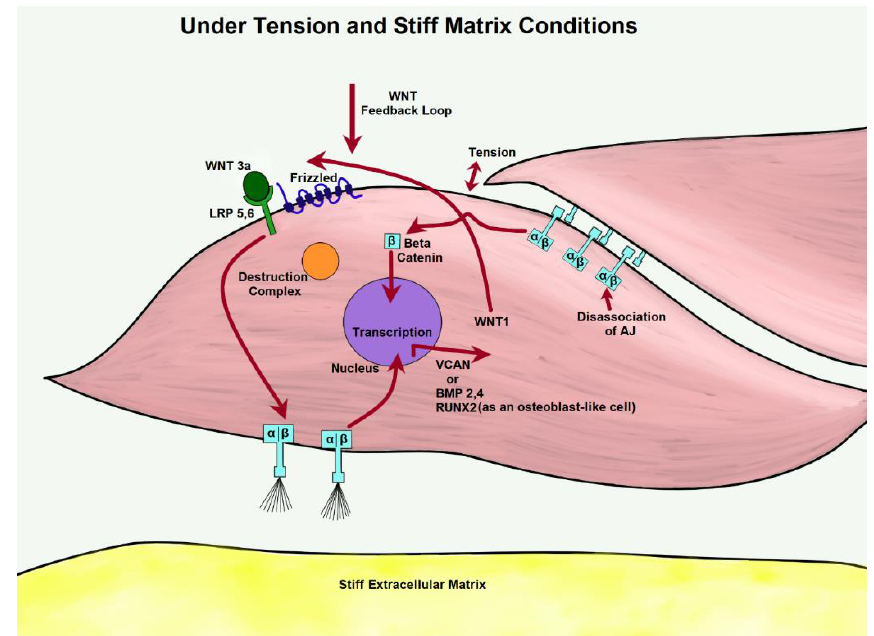
Figure 7. Through the activation of WNT, β -catenin is free to pool from tension-dissociated AJs. Under excessive tension, integrins are likely to influence WNT expression of matrix proteins.